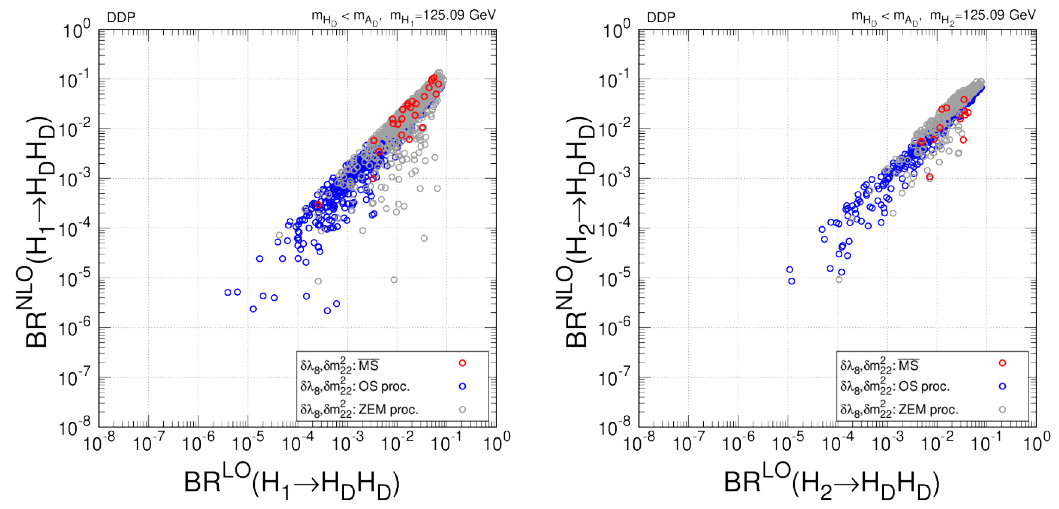
Figure 7 . Correlation between the branching ratios at NLO and at LO in scenario 1 (left) and scenario 2 (right), respectively. The red, blue and grey points correspond to the MS , OS process- dependent and ZEM process-dependent scheme,